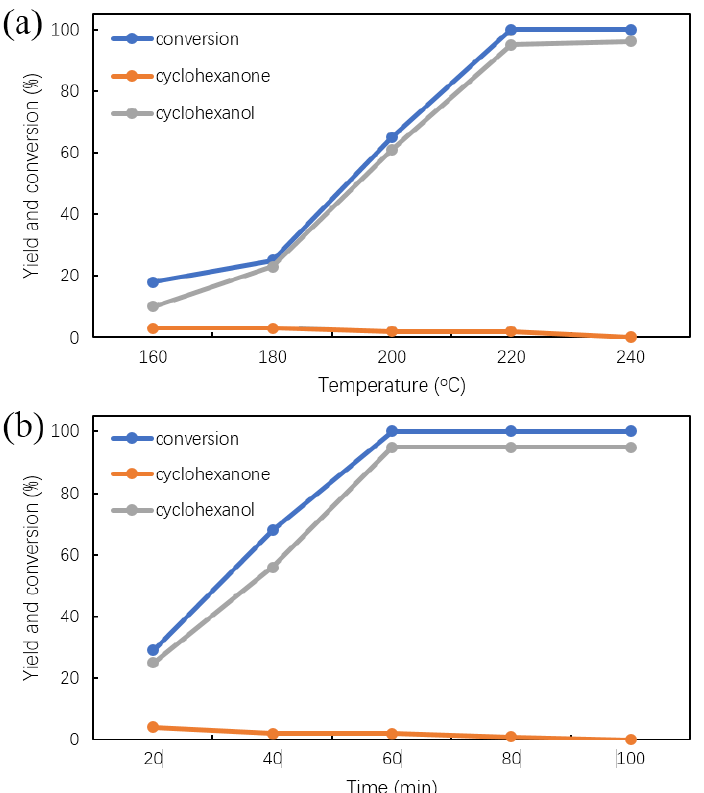
Figure 4. Influence of reaction temperature ( a ) and time ( b ) on the hydrogenation of phenol. Reaction conditions: Phenol (500 mg), 20% Ni/CNT (50 mg), isopropanol (10 mL); reaction time, 60 min (for a); reaction temperature, 220 °C (for b).